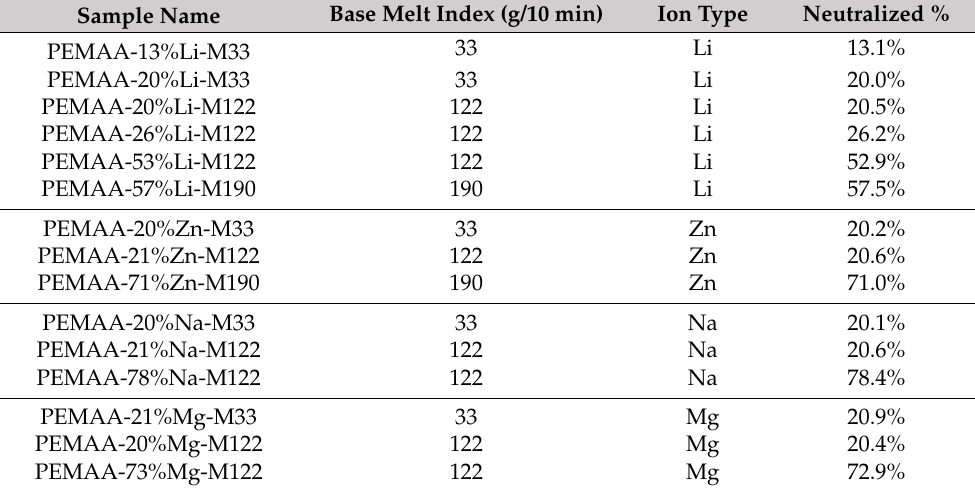
Table 1. List of polymers with the acid type of methacrylic acid (MAA), base melt index, ion type, and percentage neutralized.